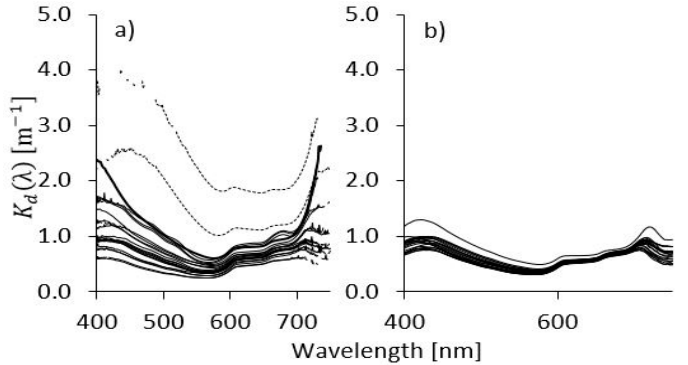
Figure 6. Field K d ( λ ) for: ( a ) 2013; and, ( b ) 2019.